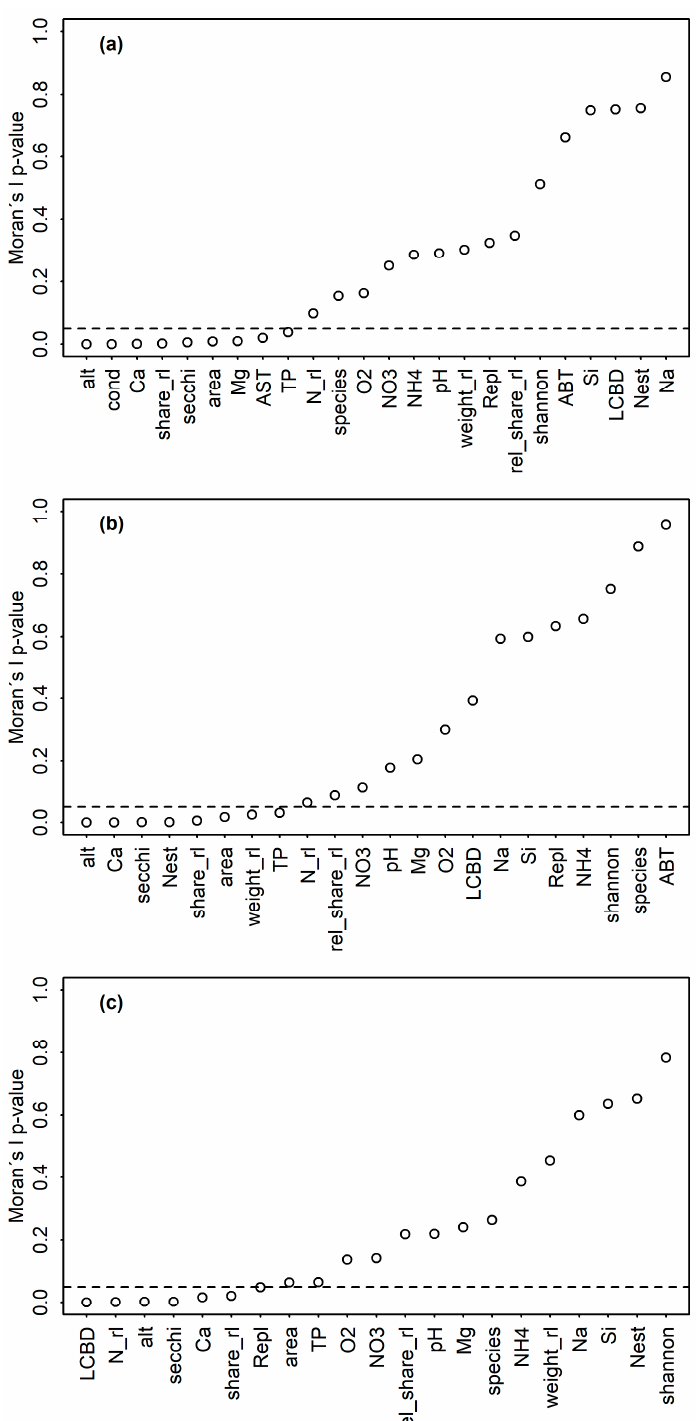
Figure 3. Moran’s I p -values for RL indices, assemblage indices and environmental variables plotted in increasing order for the ( a ) sedimentary (N = 43), ( b ) littoral (N = 34) and ( c ) planktic (N = 32) dataset. The horizontal dashed line marks a p -value of 0.05, with lower values indicating spatial autocorrelation based on longitudes and latitudes. Abbreviations of environmental parameters are explained in Table